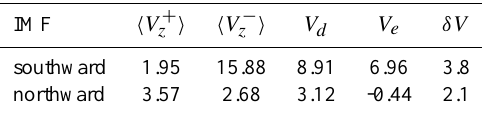
Table 3. h V z i statistics. All velocities are in